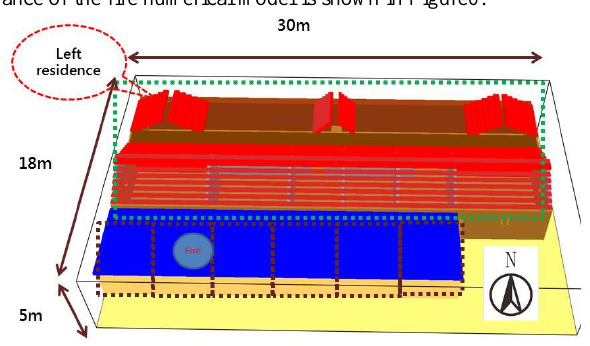
Figure6. The appearance of the fire numerical model The ignition place was set as the second cooking vendor inside from west, and the fire was located on the wooden table (height 0.8m). The vendors were built by wooden compartment in the interior, and were covered with light gauge steel roof. The simulations assumed midnight fire situation, so the vendors' gates were shut down.